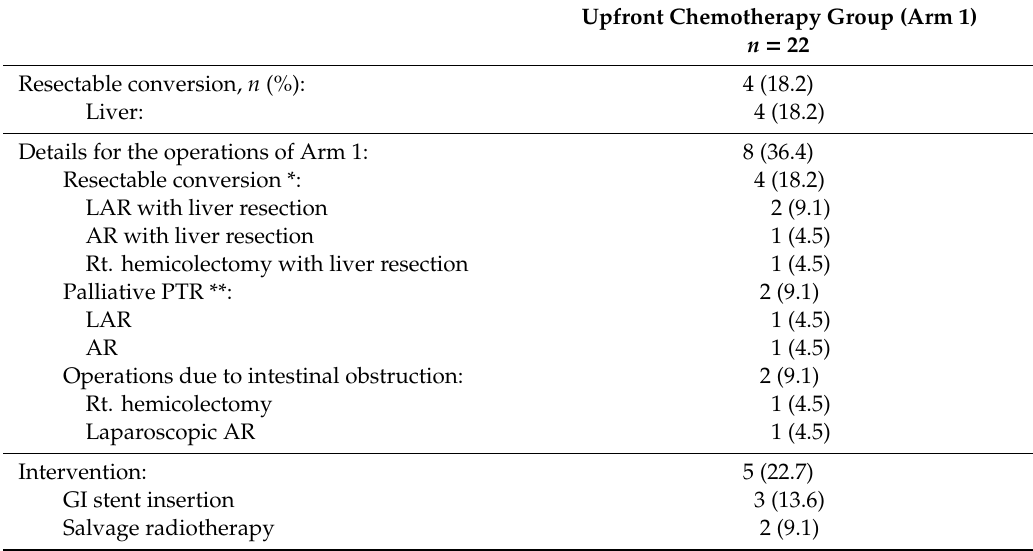
Table 2. Clinical manifestations in the upfront chemotherapy